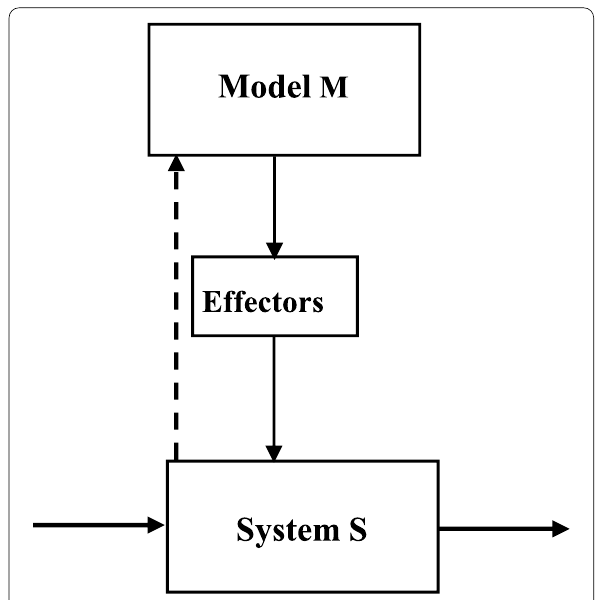
Fig. 2 The internal structure of the simplest anticipatory system